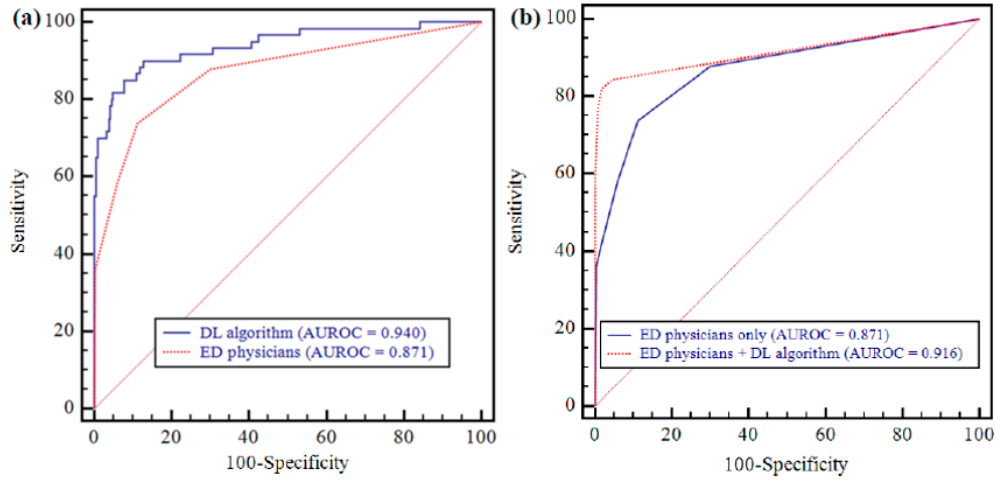
Figure 3. AUROCs of DL algorithm and ED physicians (visible pneumonia on CR vs. non-pneumonia). ( a ) The DL algorithm showed significantly higher performance than that for ED physicians (0.940 vs. 0.871; P = 0.007). ( b ) ED physicians’ performance was significantly improved after assistance with DL algorithm (0.871 vs. 0.916; P = 0.002).